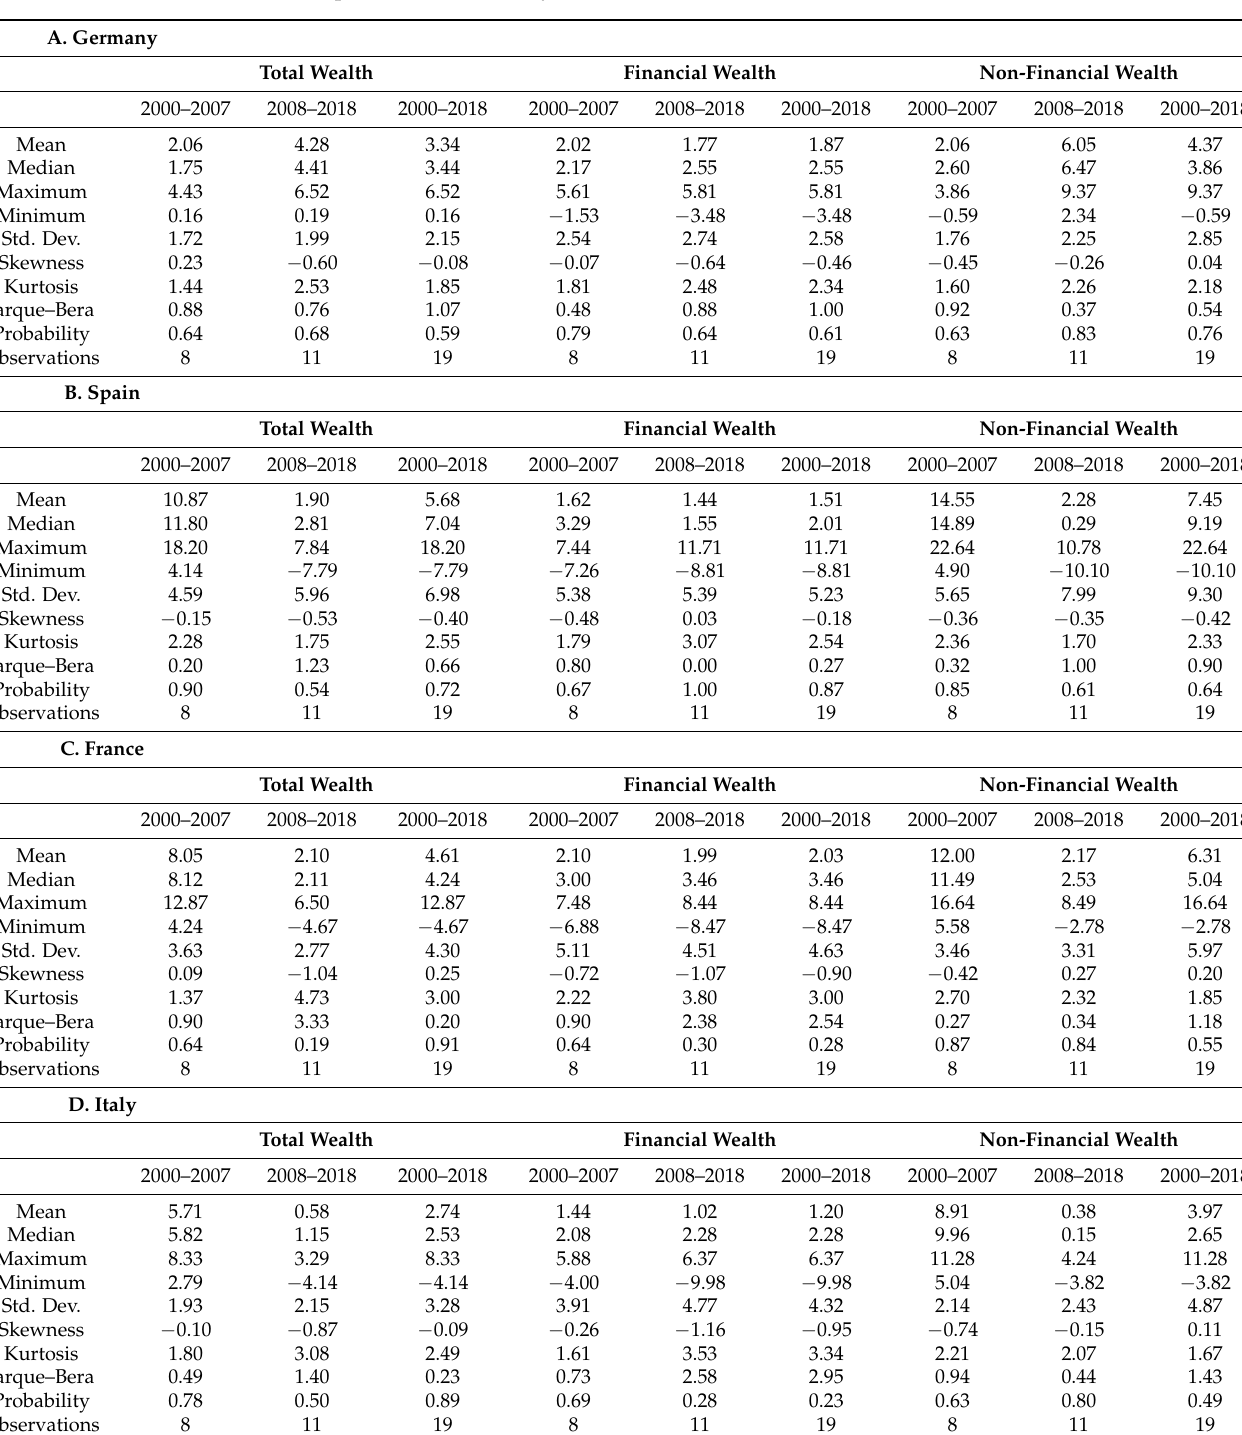
Table 1. Descriptive statistics—real yields on total, financial and non-financial